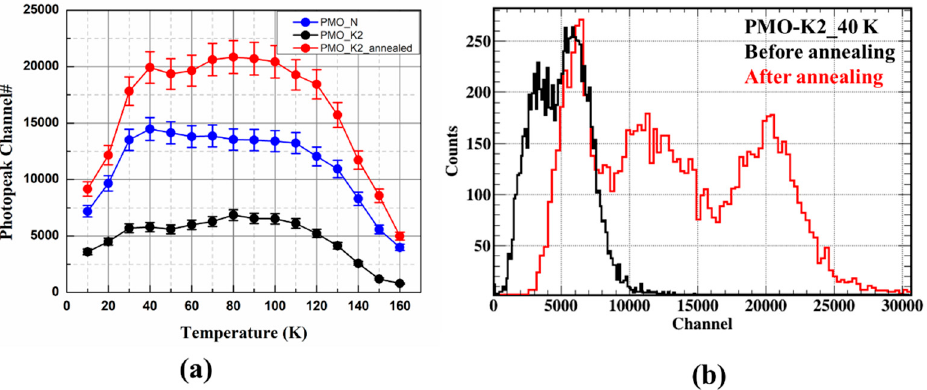
Figure 6. ( a ) Temperature dependence of scintillation light yields of PMO-K2 before (red circles) and after annealing (blue circles) in an air atmosphere and PMO-N (black circles), ( b ) pulse height distribution of PMO-K2 before (black) and after annealing (red) measured at 40 K. All these measurements were performed under 662 keV γ -ray excitation from a 137 Cs source.